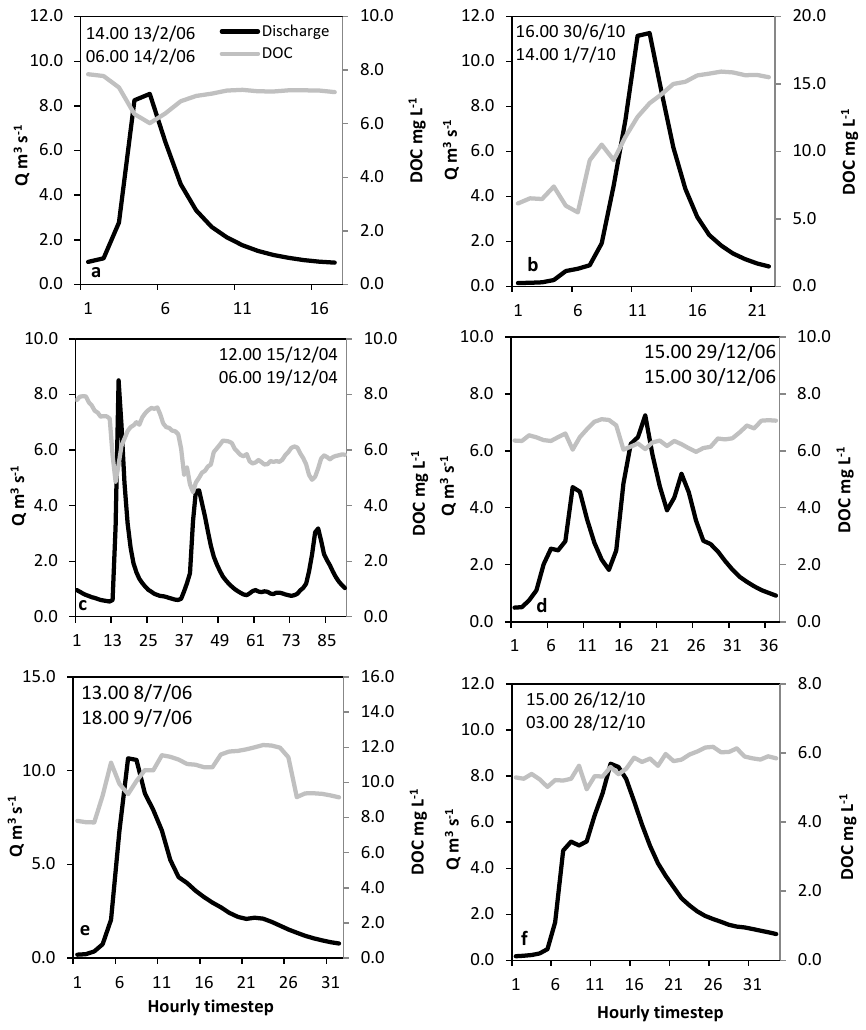
Figure 5. Estimated DOC concentrations during extreme discharge events (where discharge exceeded